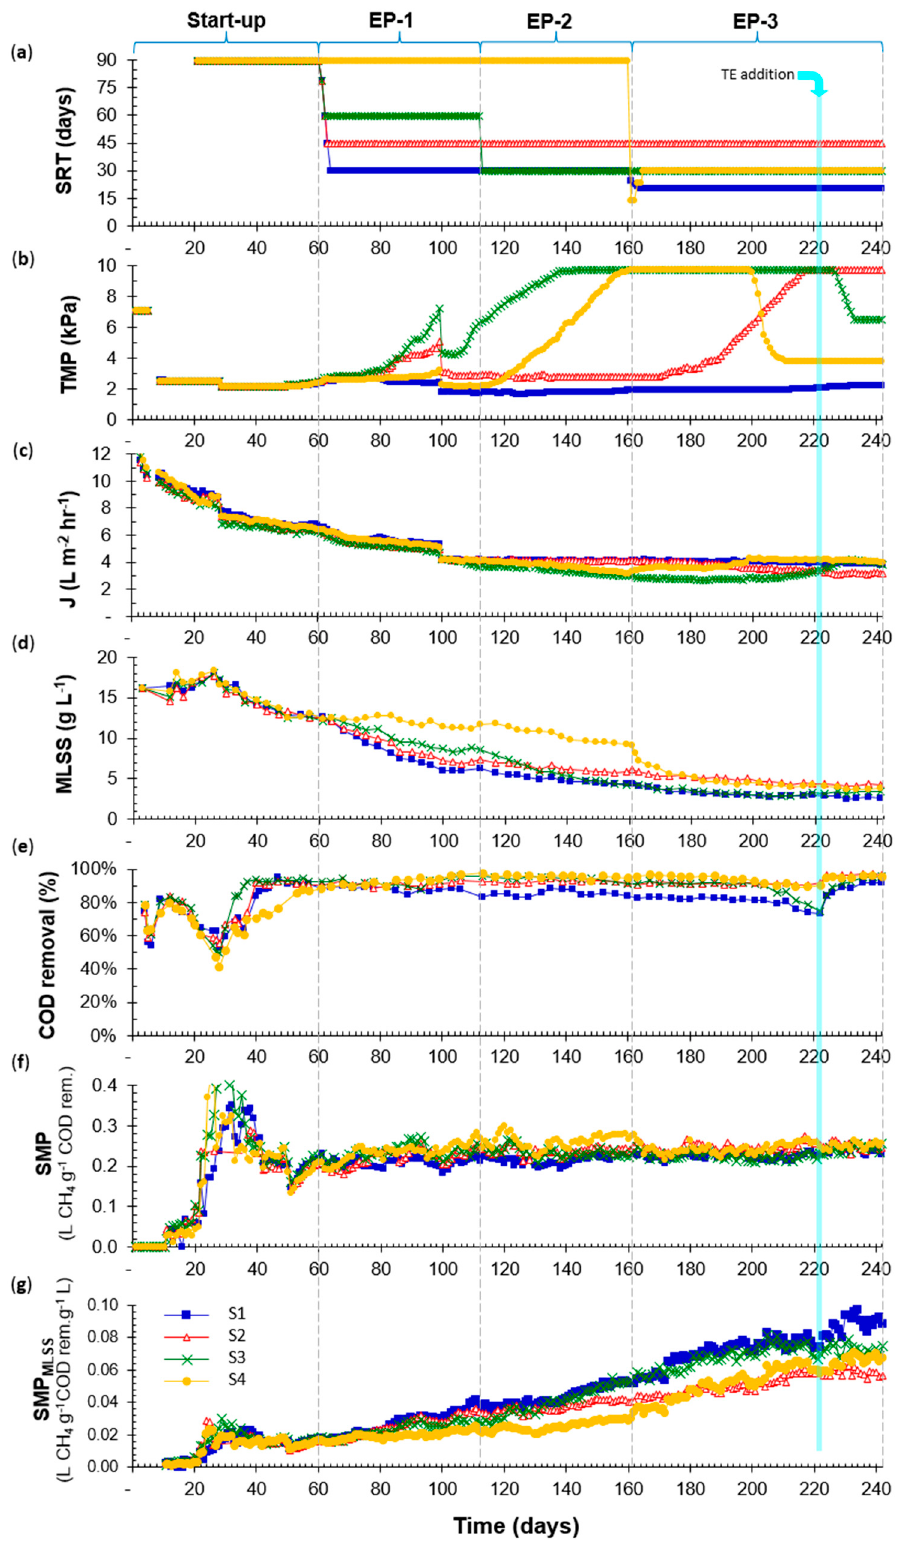
Figure 2. Operational parameters in SAnMBRs during the whole experimental period: ( a ) SRT; ( b ) TMP; ( c ) flux (daily average); ( d ) MLSS; ( e ) COD removal; ( f ) SMP; ( g ) specific SMP (MLSS basis). Vertical dotted lines indicate start of experimental phases.